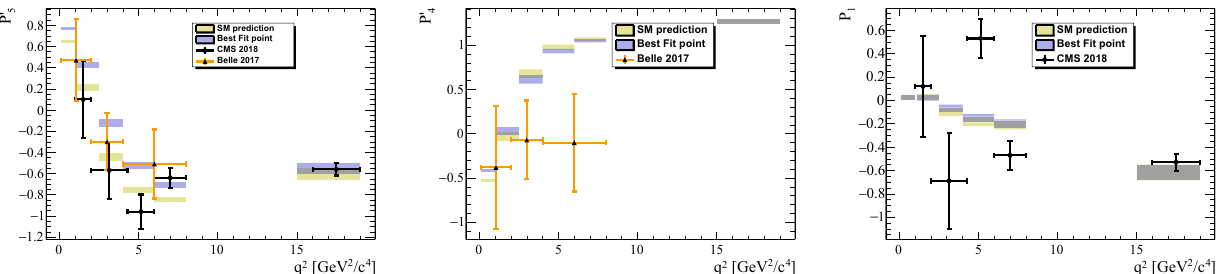
Fig. 3 Optimised angular observables for the decay B d → K ∗ 0 μ + μ − included in our fit. Yellow shading corresponds to Standard Model predictions and uncertainties, and blue shading shows the pre- diction of our best-fit model. Data points with error bars show mea- surements from Belle [50] and CMS [83]. For display purposes, we